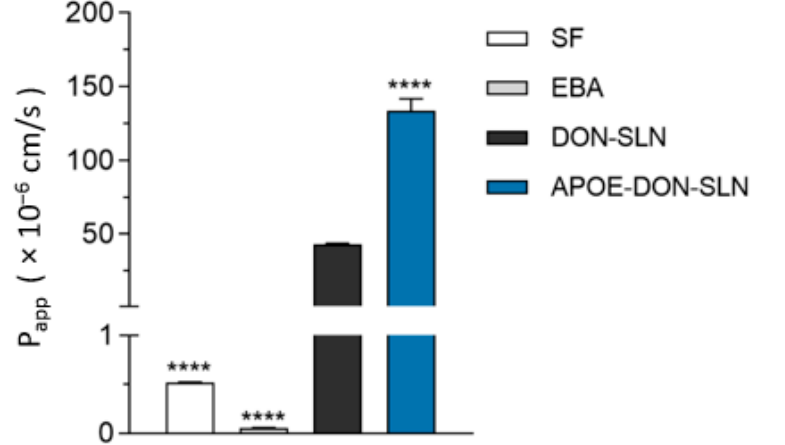
Figure 8. Permeability of RhB cargo encapsulated in non-targeted (DON-SLN) or ApoE-targeted SLNs (APOE-DON-SLN) across the BBB model (10 µ g/mL concentration, 2 h). Values presented are means ± SEM. Statistical analysis: one-way ANOVA followed by Dunnett’s posttest, where **** p < 0.0001, compared to the DON-SLN group; n = 4. P app : apparent permeability coefficient, SF: sodium fluorescein (376 Da), EBA: Evans blue-labeled bovine serum albumin (67 kDa).